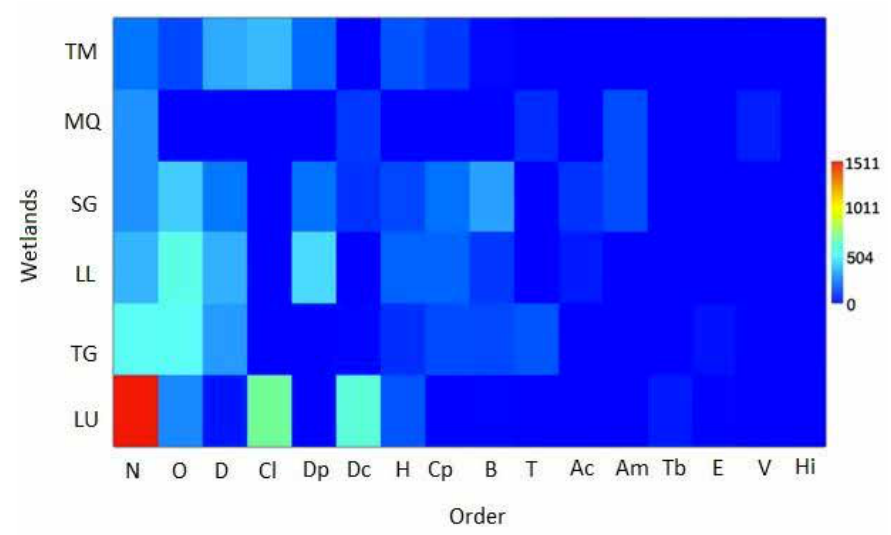
Fig. 4: Macroinvertebrate abundance heatmap in sampled wetlands. Fig. 4 : Macroinvertebrate abundance heatmap in sampled wetlands.